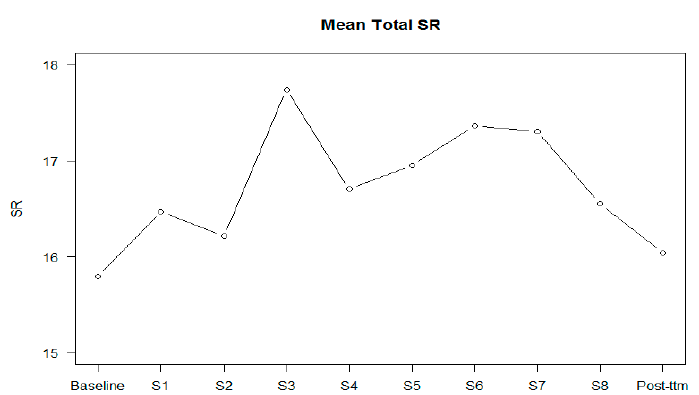
Figure 3. Mean of self-reflectiveness (SR) in each session and in the